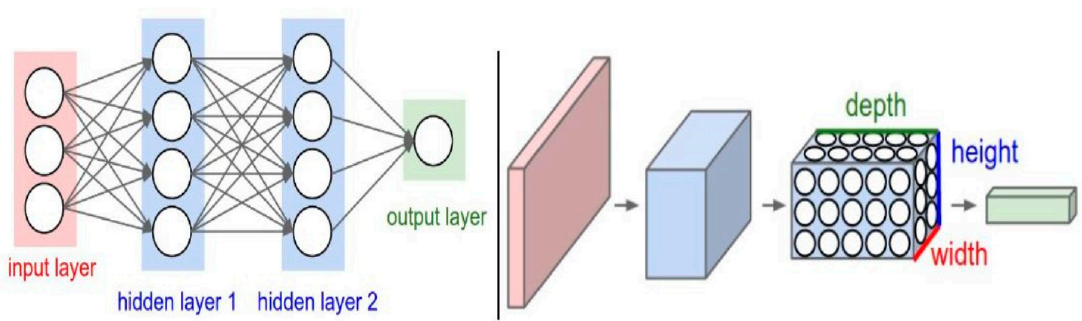
Figure 2. ( Left ) A typical neural network showing the interconnection of weights among all layers. ( Right ) Convolutional neural network (CNN) architecture with different layers with locally interconnected 3-dimensional weights [12].